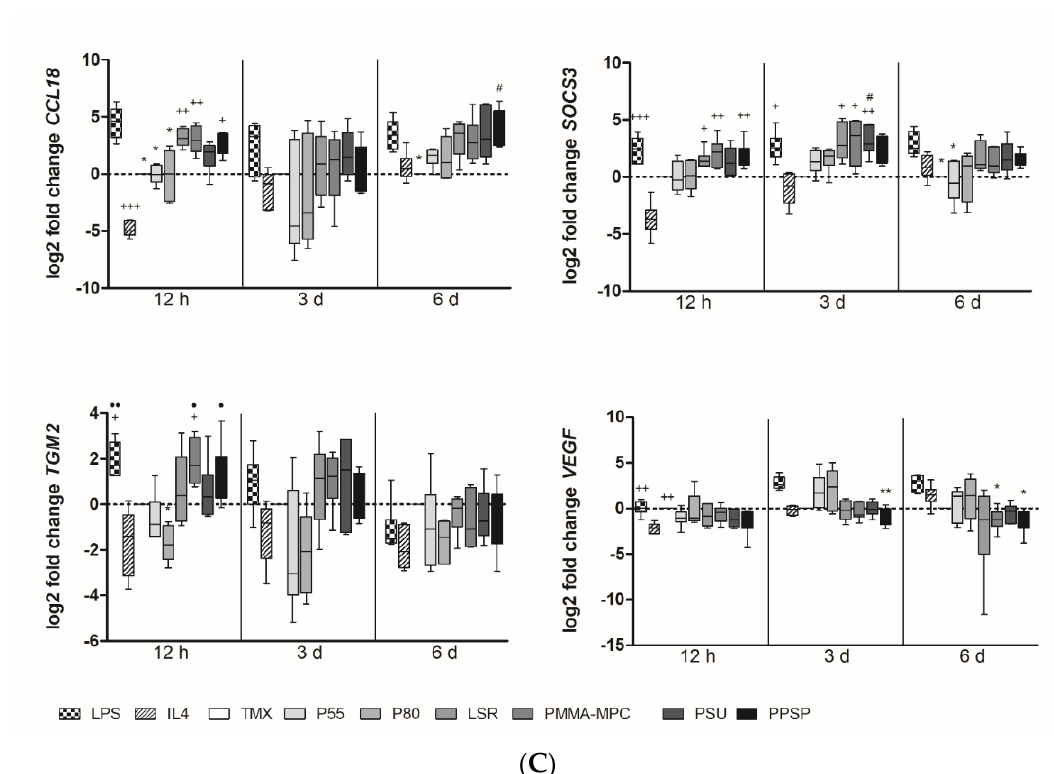
Figure 3. Unmodified and modified liquid silicon rubbers (LSR) trigger an unpolarized immune response. ( A ) Relative gene expression of IL1b , IL6, TNF α , and CCL2 was determined by real-time PCR. (B) Relative gene expression of MRC1, IL10, and TGF β was determined by real-time PCR. (C) Relative gene expression of CCL18 , SOCS3, TGM2, and VEGF was determined by real-time PCR. Data are represented as mean + SE Mean of 6 independent experiments. Significant results are indicated as * p < 0.05; ** p < 0.01; *** p < 0.001 vs. LPS; + p < 0.05; ++ p < 0.01; +++ p < 0.001 vs. IL4; # p < 0.05; ## p < 0.01 vs. TMX; • p < 0.05; •• p < 0.01 vs. P80.